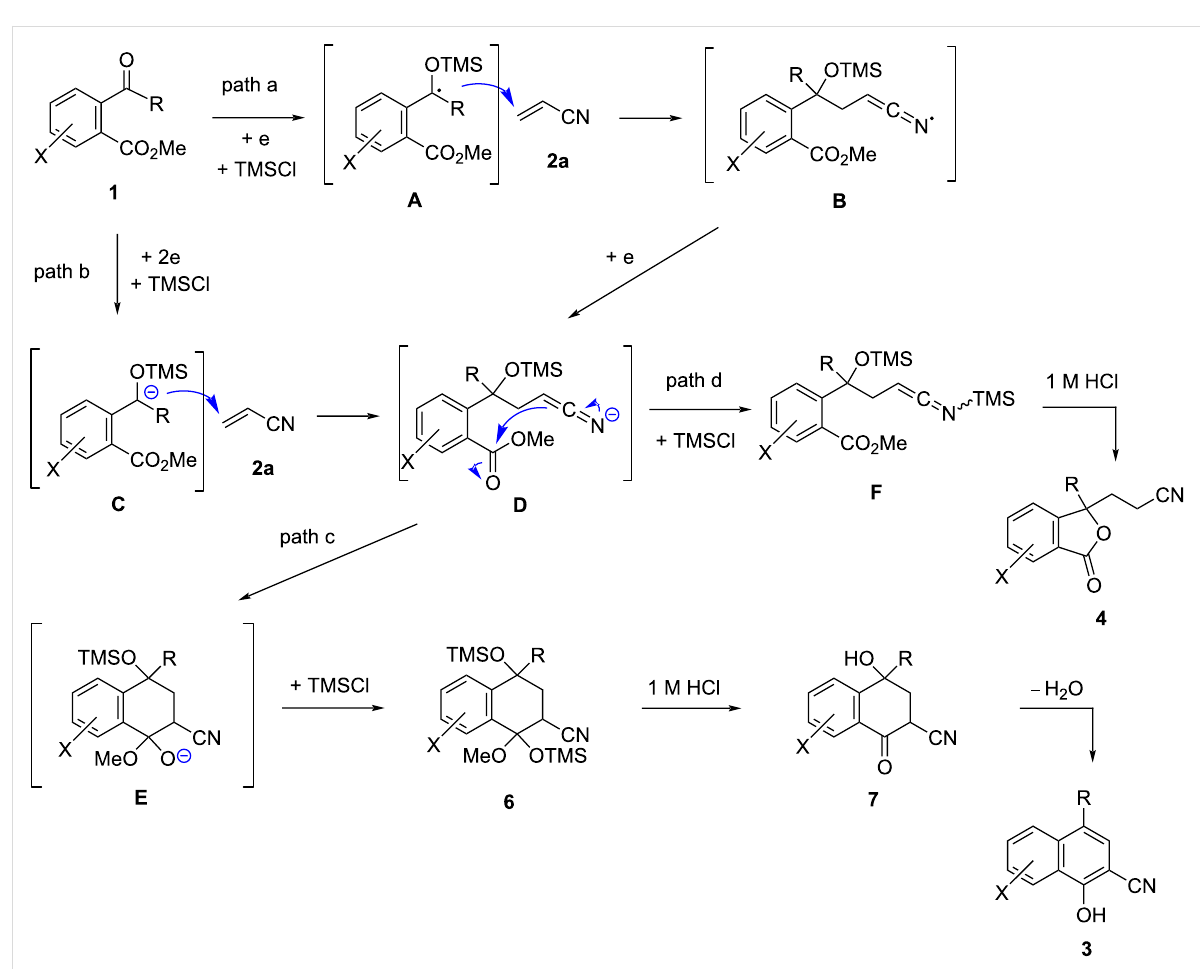
Scheme 5: Presumed reaction mechanism of electroreductive coupling of 1 with 2a and subsequent transformation to products 3 and 4 .